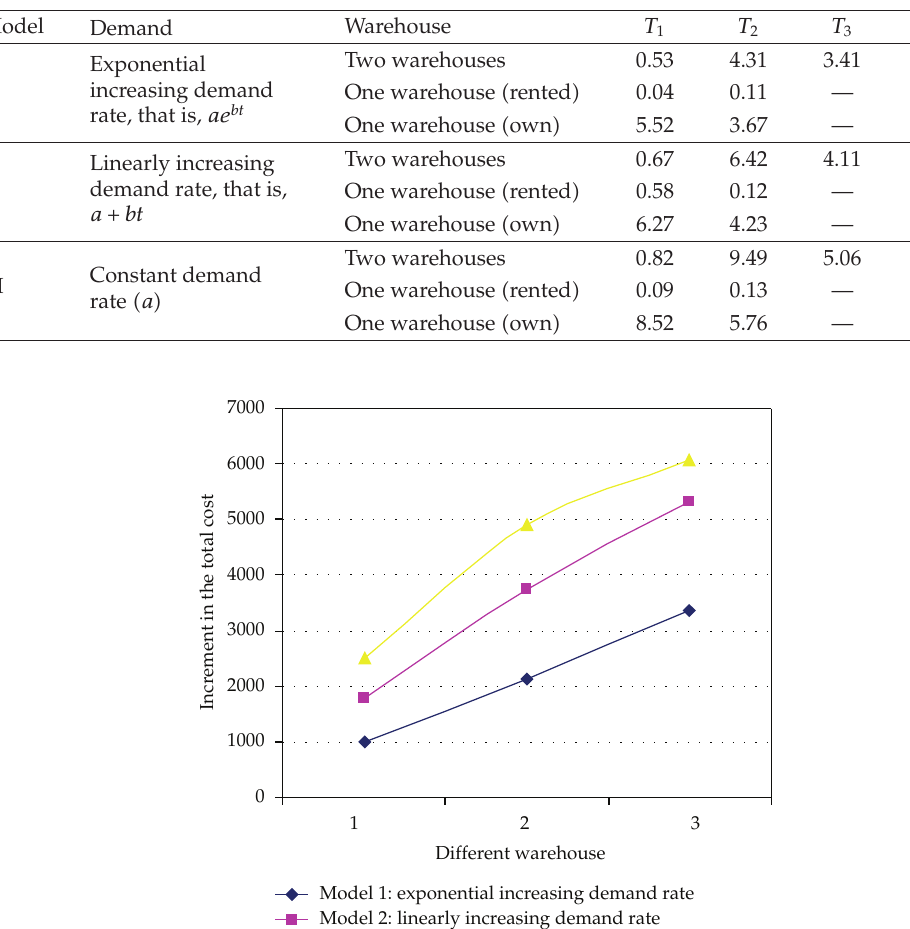
Table 1: Comparison of models with di ff erent demand patterns.